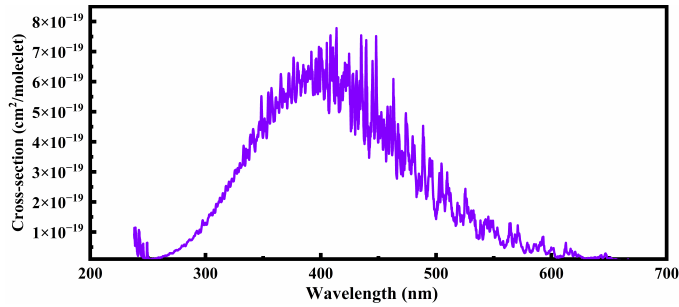
Figure 1. Cross-section of NO 2 in